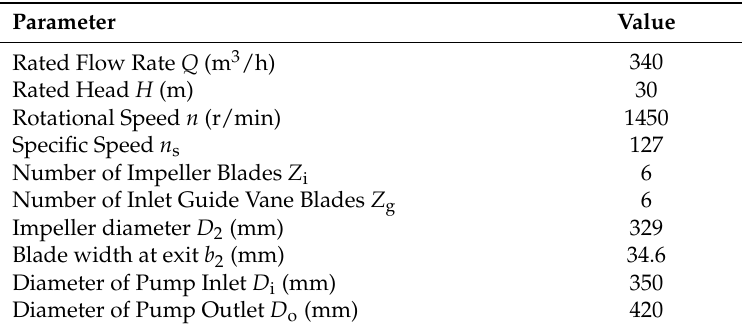
Table 1. Parameters for the centrifugal pump.